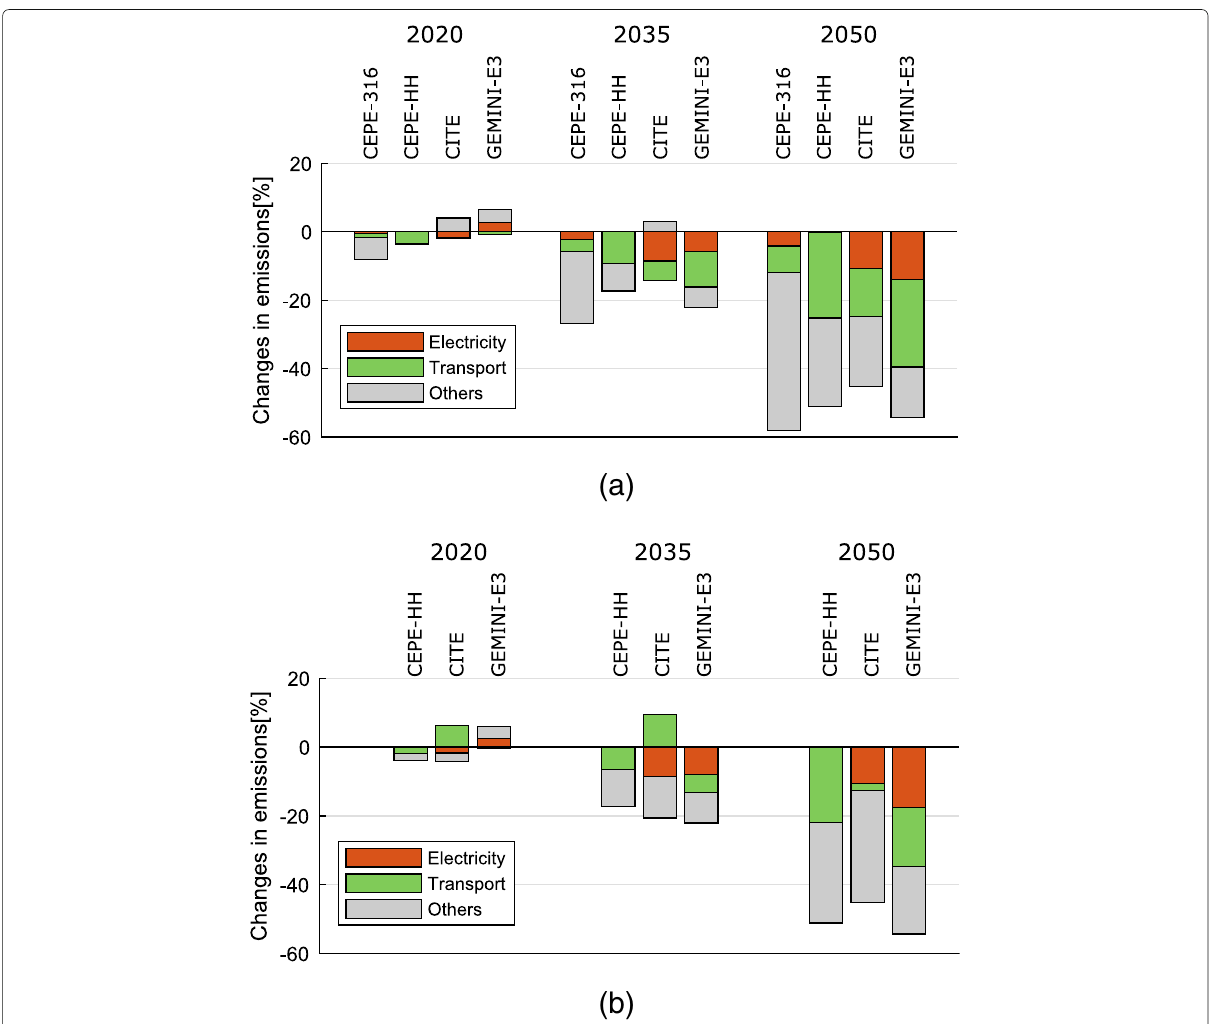
Fig. 10 Changes in emissions relative to BAU for different years for the scenarios a 1.5ETS_uni and b 1.5ETS_diff by economic